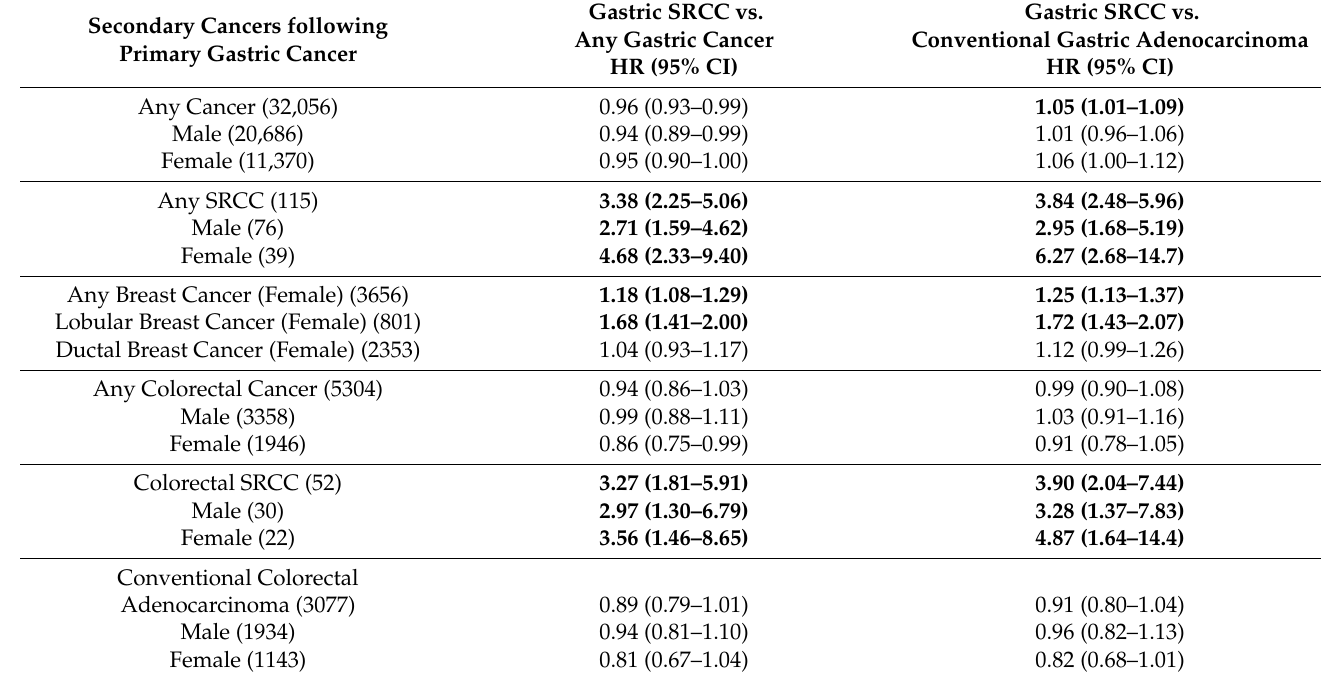
Table 5. Estimated hazard risk ratios (HR) with 95% confidence intervals (CI) for secondary cancers among patients with a primary sporadic gastric SRCC compared to other patients with any other gastric cancer type and conventional gastric adenocarcinoma from